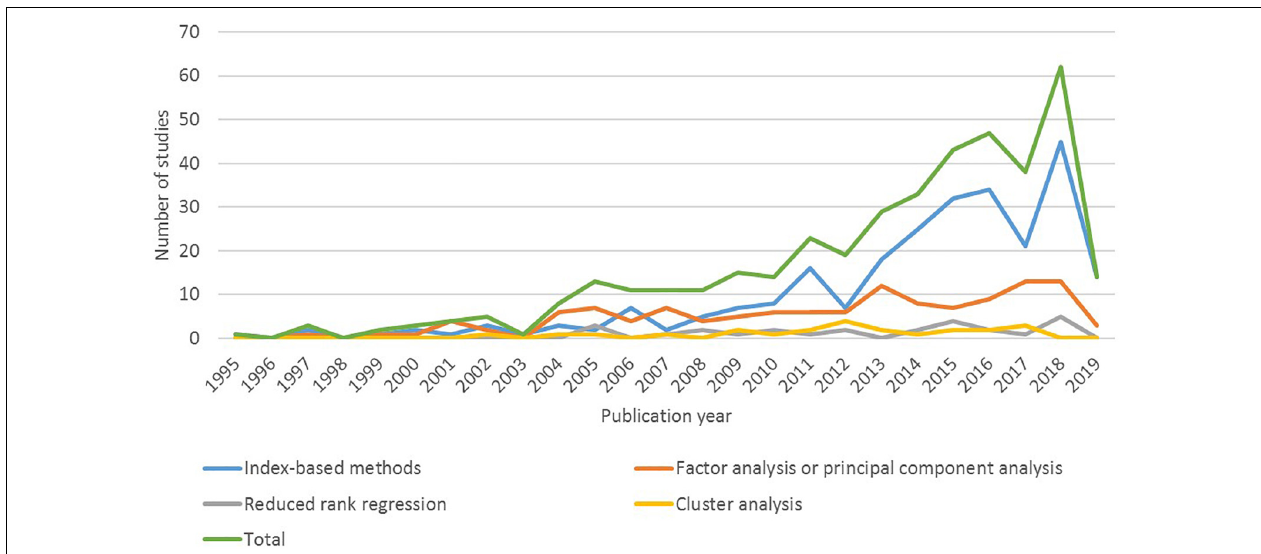
FIGURE 2 | Dietary patterns studies classified according to dietary pattern assessment method and publication year ( n = 410